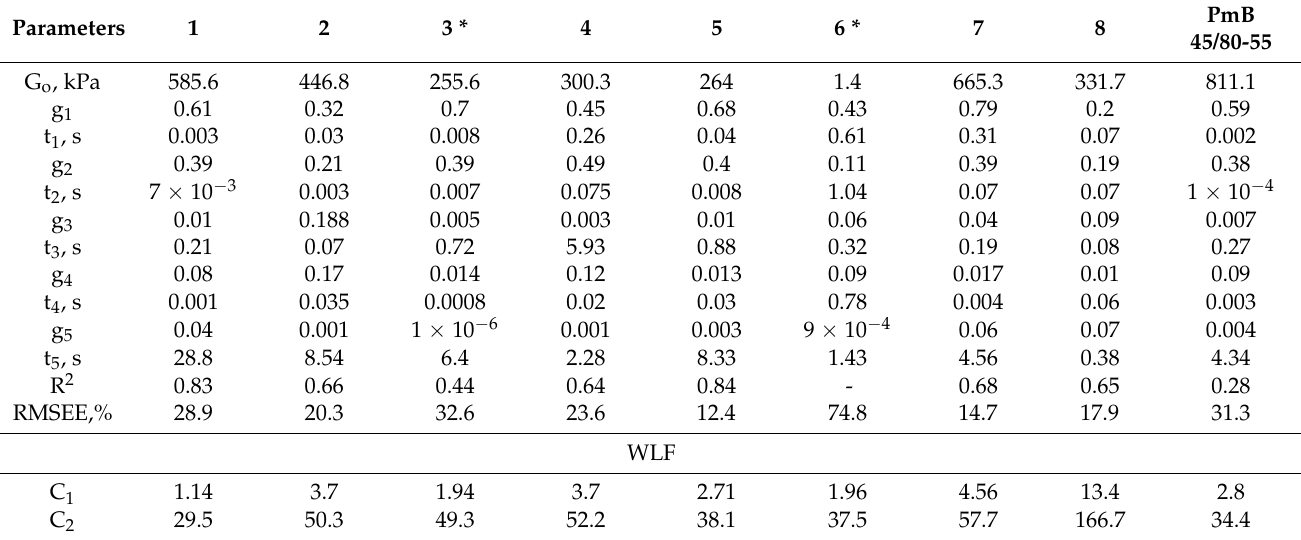
Table 5. Generalised Maxwell Model